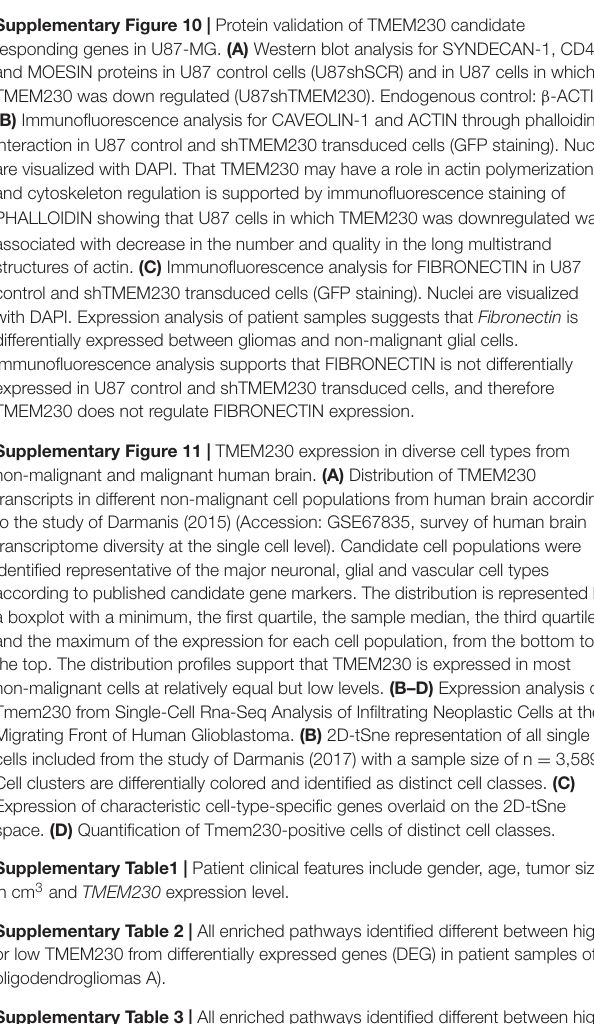
Supplementary Figure 1 | Representative enriched pathways identified from differentially expressed Genes in patient derived oligoastrocytoma with high and low TMEM230 expression. Supplementary Figure 2 | Representative enriched pathways identified different between high or low TMEM230 expression from differentially expressed genes (DEG) in patient samples of oligoastrocytoma.